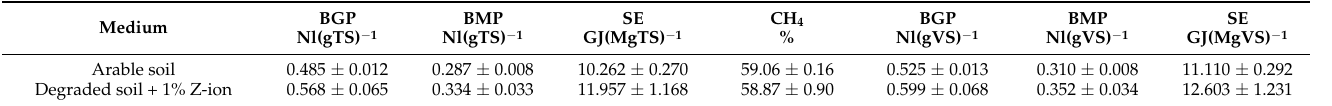
Table 4. Biogas and biomethane potentials and specific energy of cocksfoot